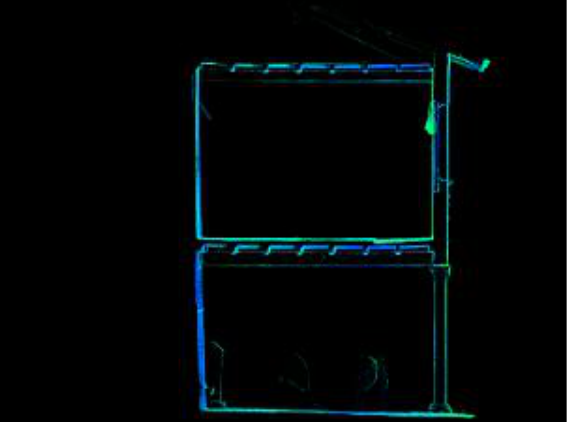
Figure 9. Image 9 allow to analyse the composition of the ceilings of each floor and the existing deformations.